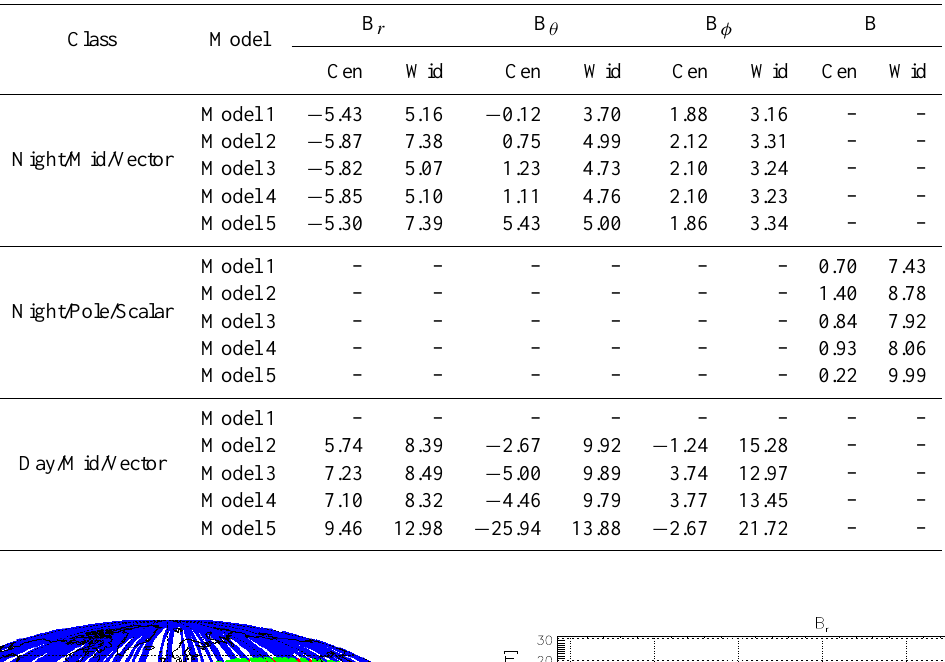
Table 2. Gaussian fit parameters of the residual error distributions for Models 1–5.